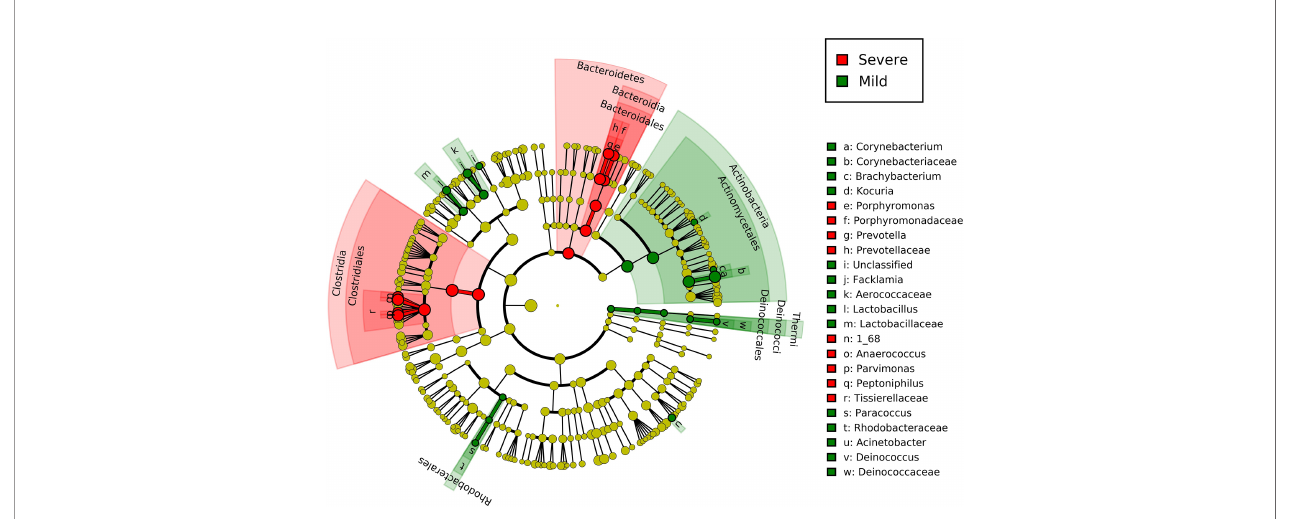
FIGURE 3 | Linear discriminant analysis effect size of group-speci fi c microbes in patients with different severities of paronychia. The in fl ammation-speci fi c microbes with biomarker signi fi cance are shown in the colored taxonomy cladogram using the LEfSe analysis. The RA differences with P < 0.05 and LDA ≥ 2.0 were regarded as microbial features with discriminative signi fi cance. The severe paronychia-speci fi c microbes are marked red in the cladograms and the mild paronychia-speci fi c microbes are marked